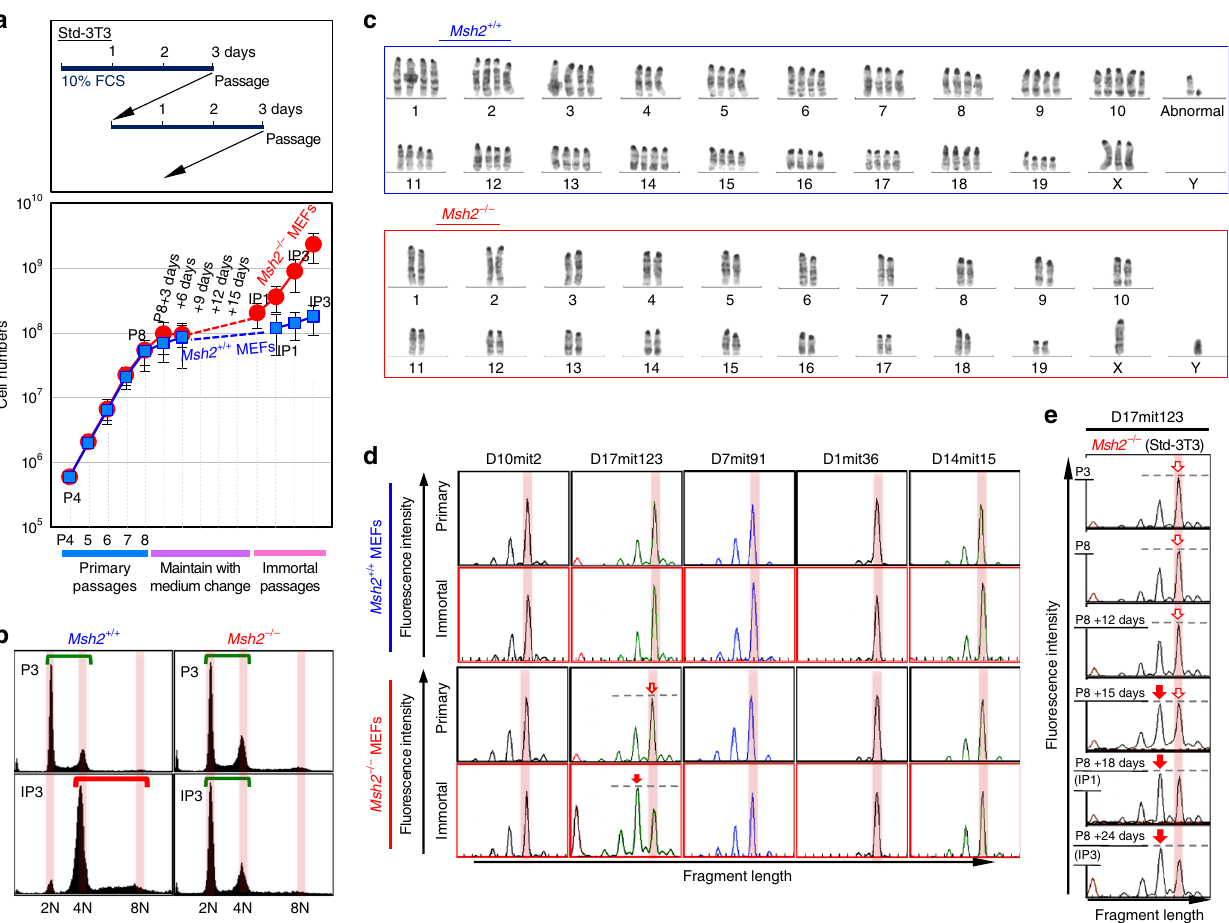
Fig. 1 MSI is induced as an alternative to CIN in MMR-de fi cient cells. a Msh2 + / + and Msh2 − / − MEFs were cultivated under the Std-3T3 protocol to monitor the immortalization process. The graph shows mean cell numbers ± s.d. ( n = 3 independent experiments with MEFs prepared from independent fetuses). b , c CIN-induction statuses were determined by fl ow cytometry ( b ) and G-band analysis ( c ). Green and red bars in b indicate diploidy